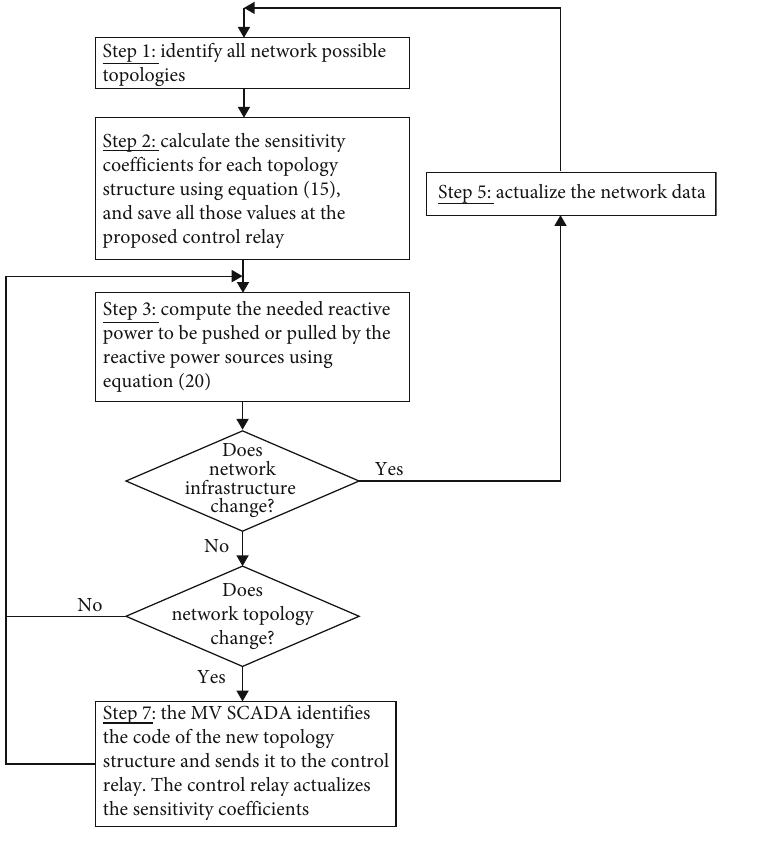
Figure 3: Flowchart diagram. Table 2: Site and size of voltage regulation